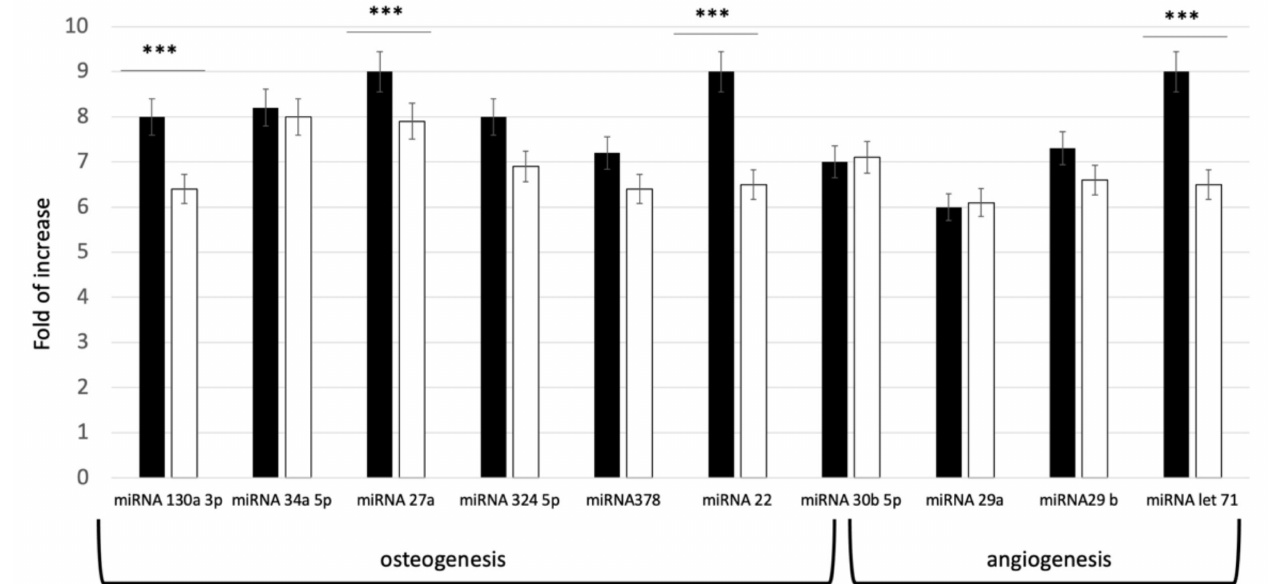
Figure 2. Expression levels of specific miRNA related to Osteogenesis and Angiogenesis pathways in young (black bar) and old (white bar) donors. *** p <